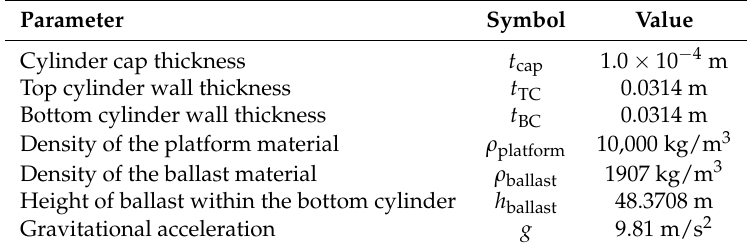
Table 5. Assumed values of the undefined spar-buoy and system